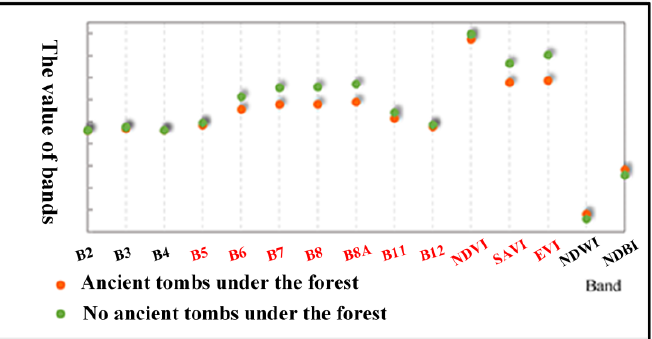
Figure 10. Average value of bands in Sentinel-2 in August 2019.